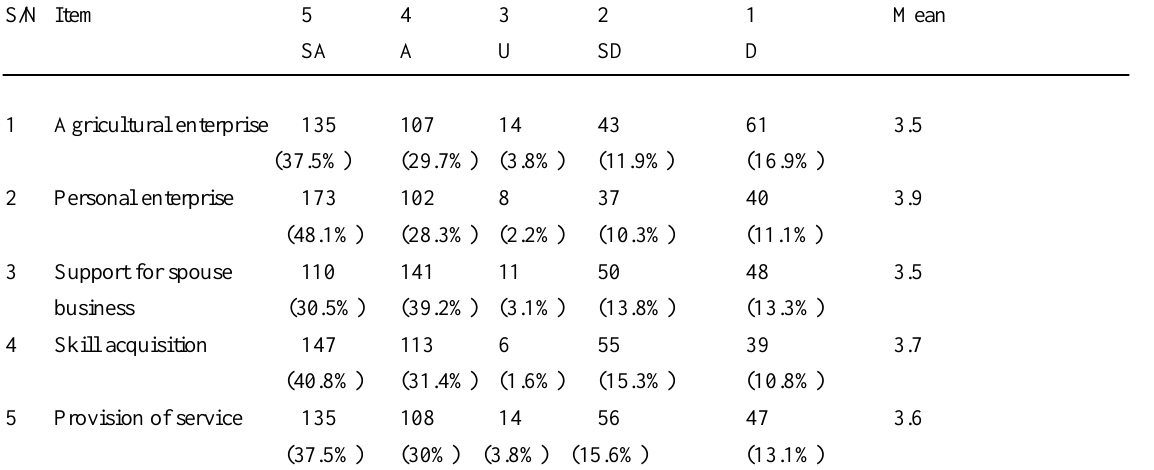
Total number of respondents = 360 Grand Mean =